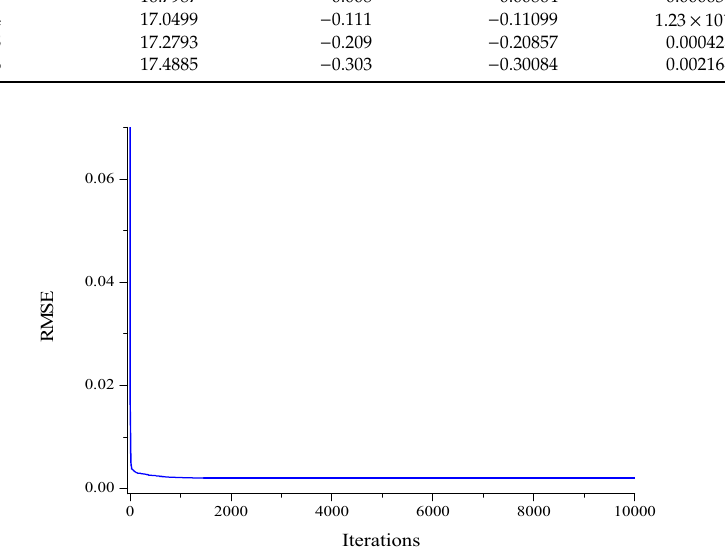
Figure 15. Convergence curve for the double-diode module.